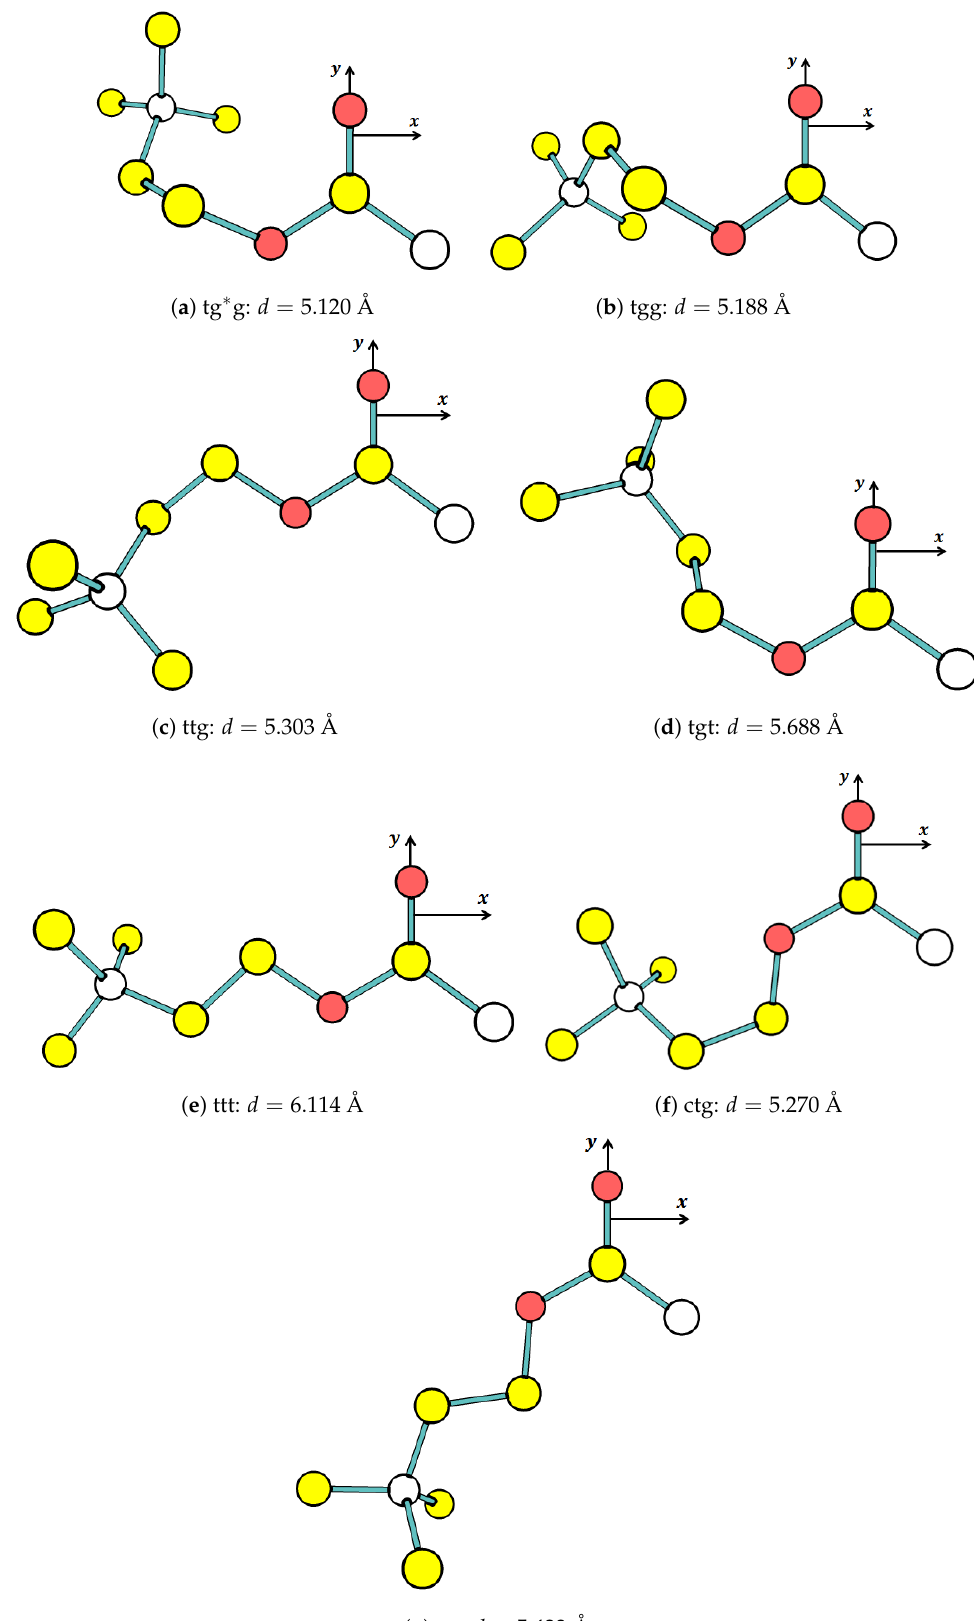
Figure 3. The optimized structure of ACh + conformers: For clarity, all H atoms are not displayed. The distance, d , is between C2 and N atom